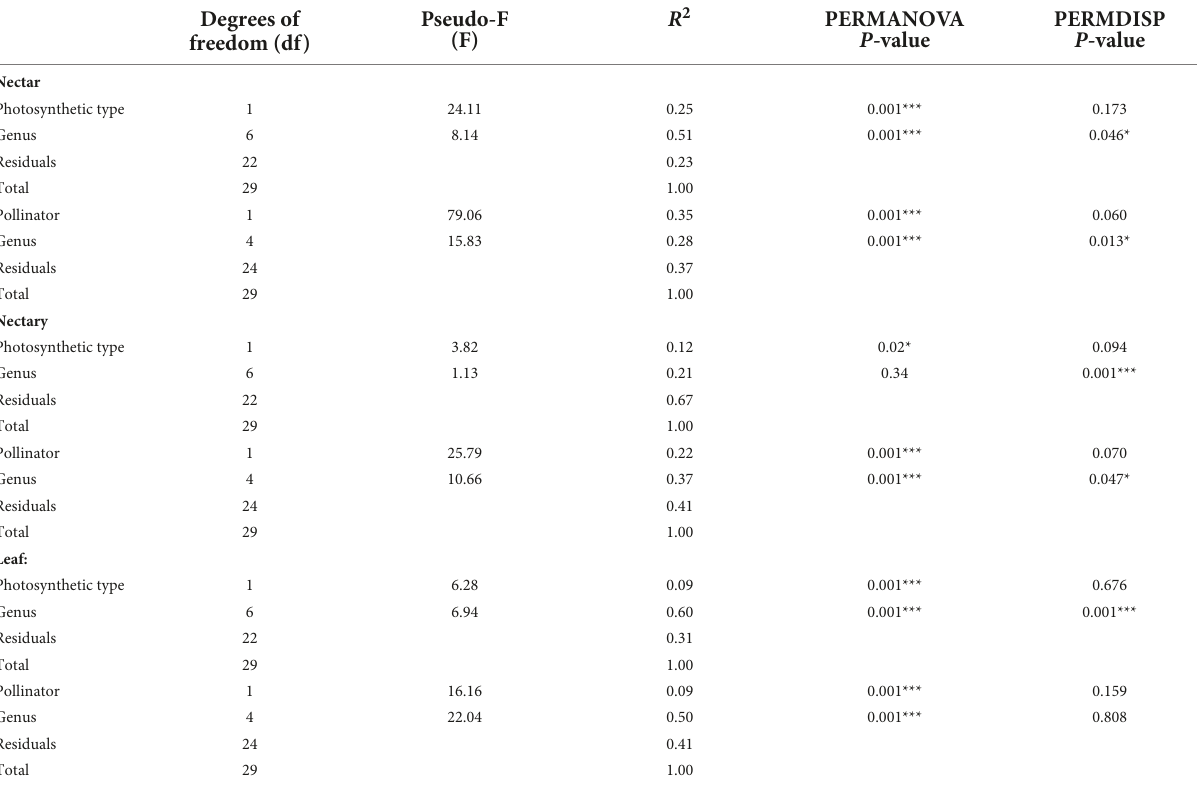
TABLE 3 Results of the PERMANOVA and PERMDISP: Degrees of freedom (df), pseudo-F (F), R 2 , and p -values. R 2 PERMANOVA Degrees of Pseudo-F P (F) freedom (df)